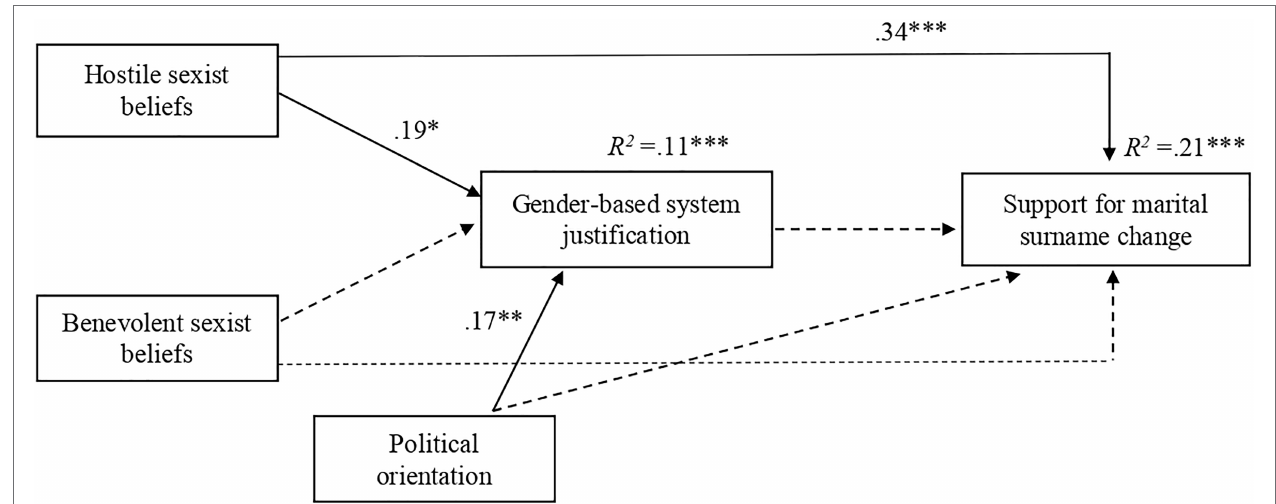
FIGURE 3 | The results of mediation analysis in Study 2. Standardized regression coefficients for the relationship between hostile and benevolent sexism (IVs) and support for marital surname change (DV) as mediated by gender-based system justification and controlled for political orientation, *** p < 0.001, ** p < 0.01, * p < 0.05. Non-significant paths are shown as broken